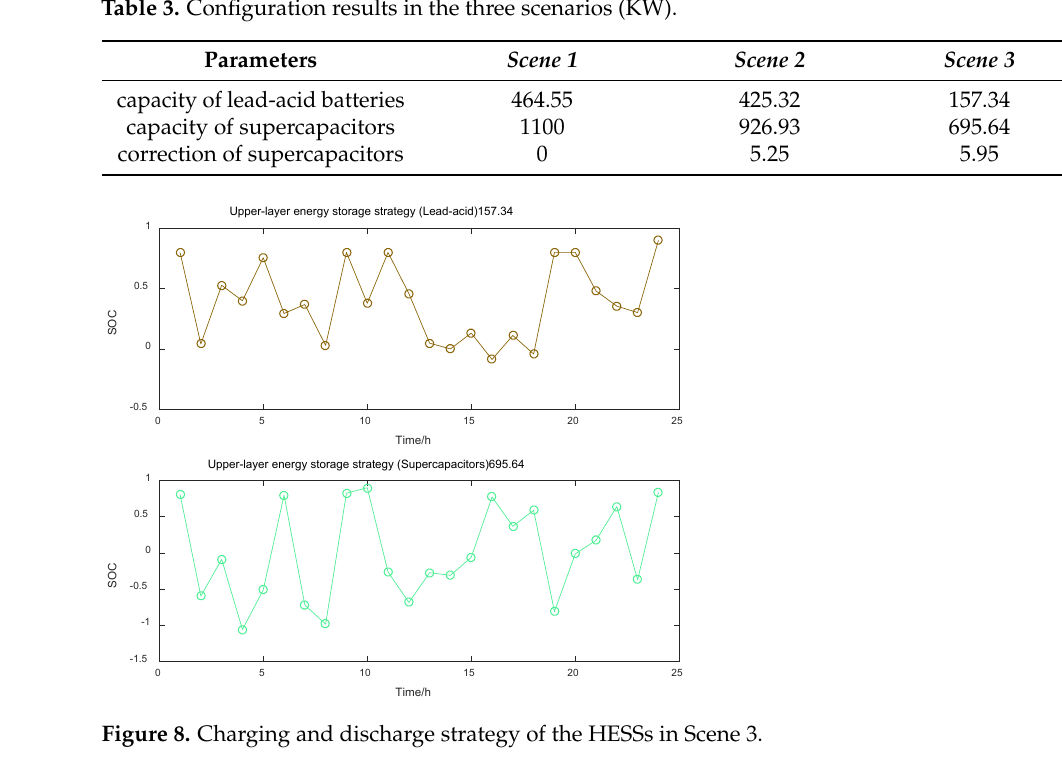
Table 4. The cost profiles of the configuration schemes (RMB).